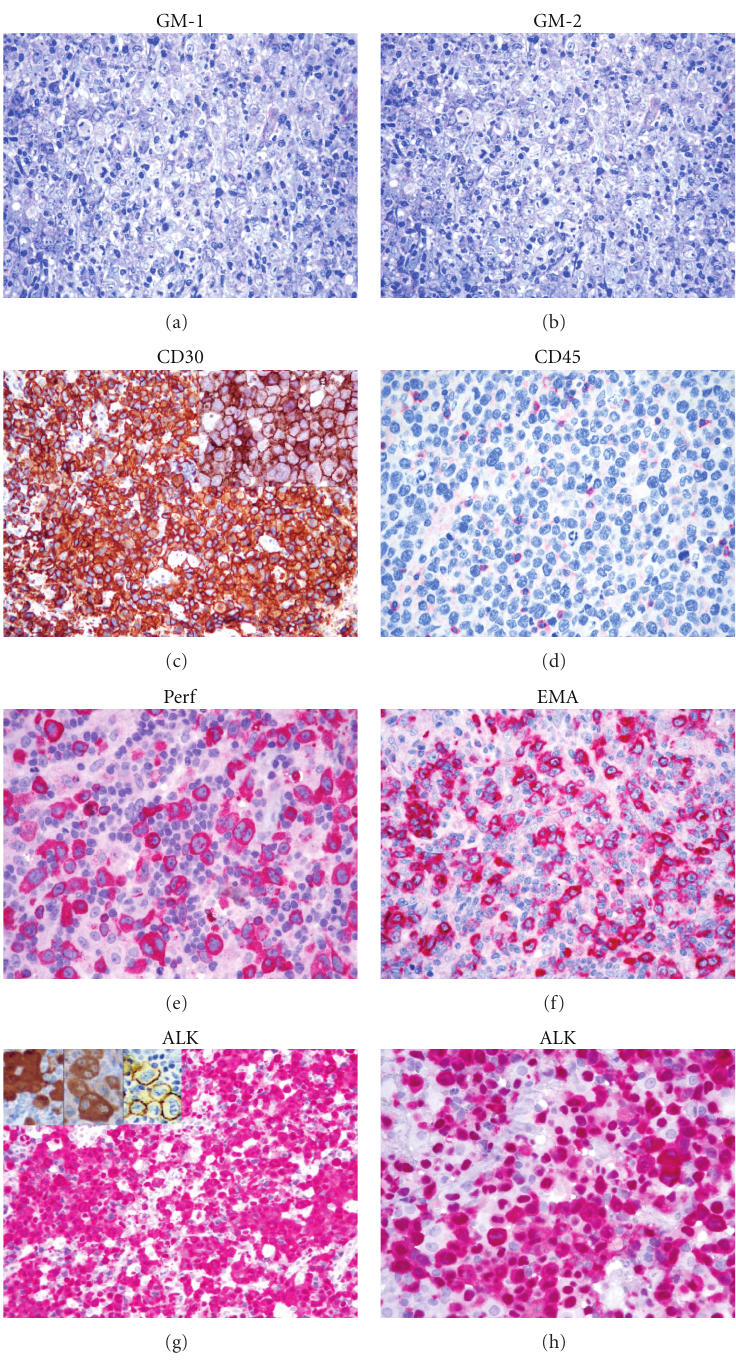
Figure 1: Morphological and immunophenotypical features of ALCL. At morphology (GM), a variable amount of hallmark cells can be identified, the phenotype being typically CD30 + , and possibly CD45 − , EMA + , and Perforin (Perf) + . In ALK + cases, ALK staining more frequently interests both nucleus and cytoplasm, being associated with NMP1/ALK translocation. However, di ff erent transcripts may determine an isolated cytoplasmic or membranous staining (see insets; refer to Table 1 for